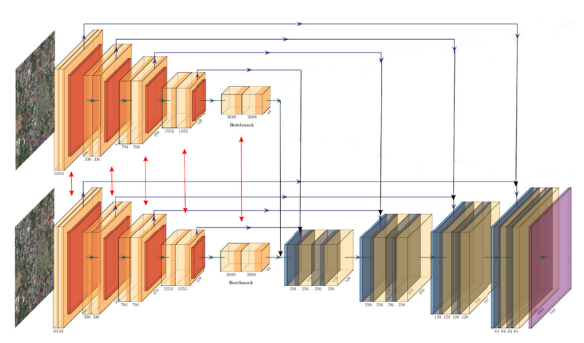
Figure 5. Architecture of Siamese